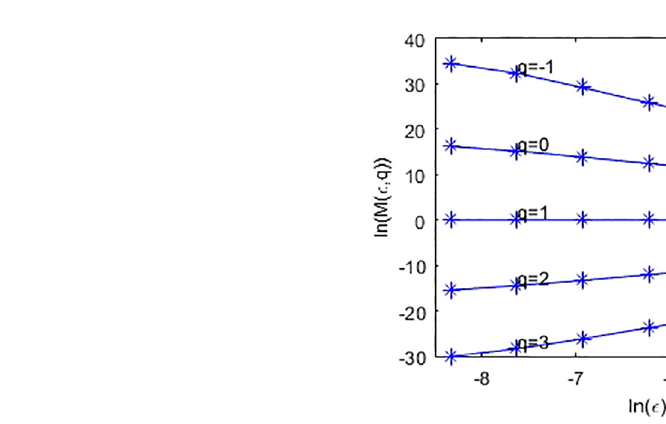
for computing the multifractal dimensions of 100 simulated metagenomes from dataset 1 and 6 h 50 m 42 s for computing the multifractal dimensions of 100 simulated metagenomes from dataset2.